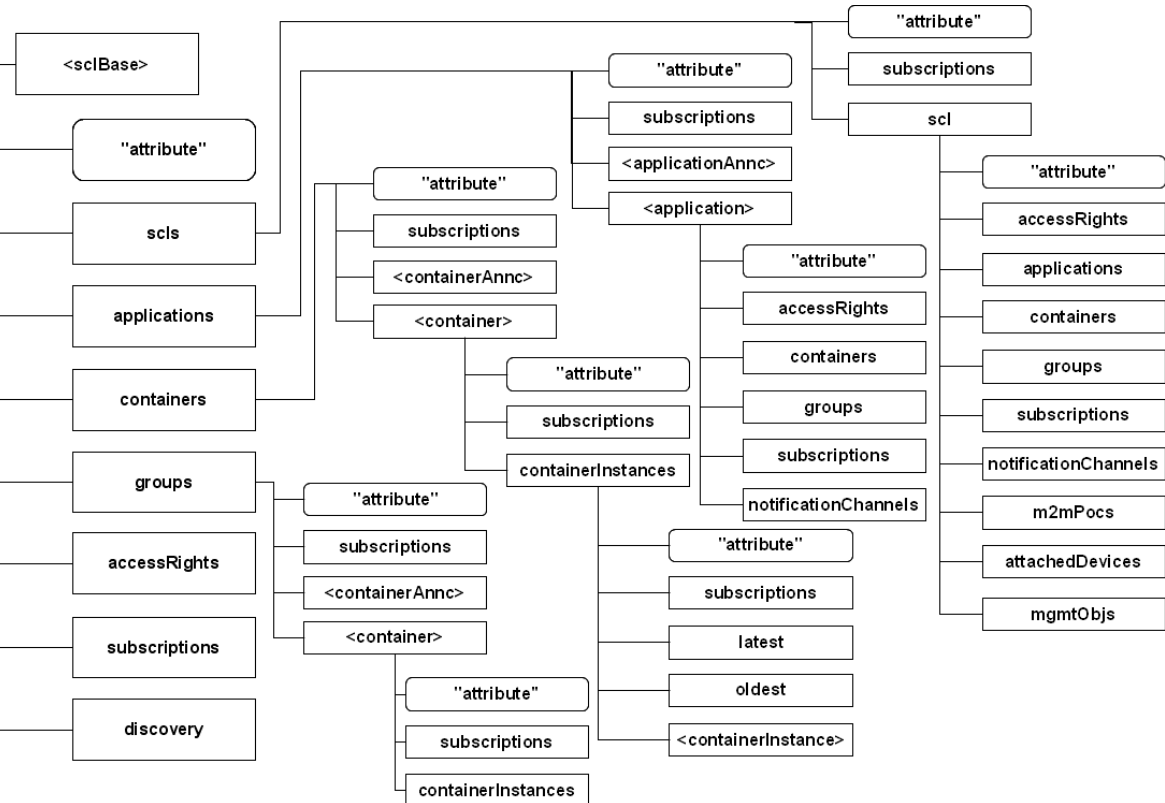
Figure 9. An example Service Capability Layer (SCL) resource